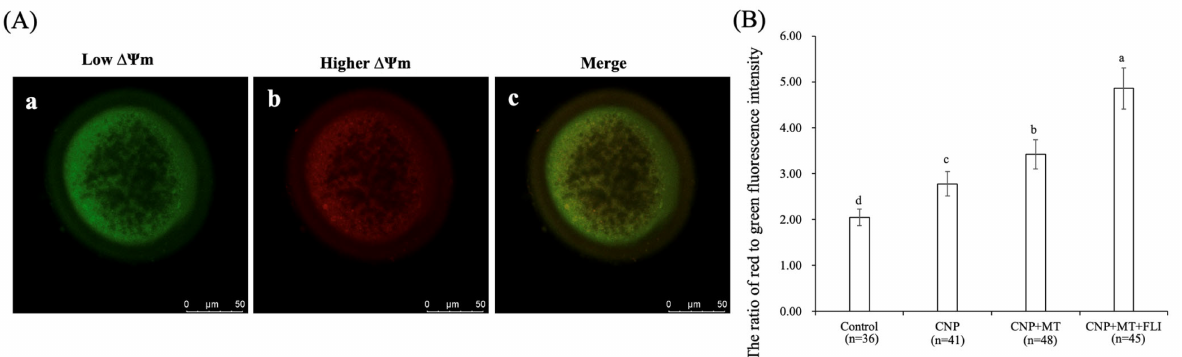
Figure 4. E ff ect of the combination treatment CNP, MT, and FLI on the ΔΨ m in bovine oocytes. ( A ) Representative image staining of JC-1 staining in bovine oocytes. a: Green: JC-1 monomeric form (low ∆Ψ m); b: Red: JC-1-aggregated form (higher ∆Ψ m); c: merging of images with green and red fluorescence. Bar = 20 µ m. ( B ) Effect of CNP+MT+FLI on the ratio of red to green fluorescence intensity in bovine oocytes. a, b, c, d Values with different superscripts indicate significant differences between groups ( p <